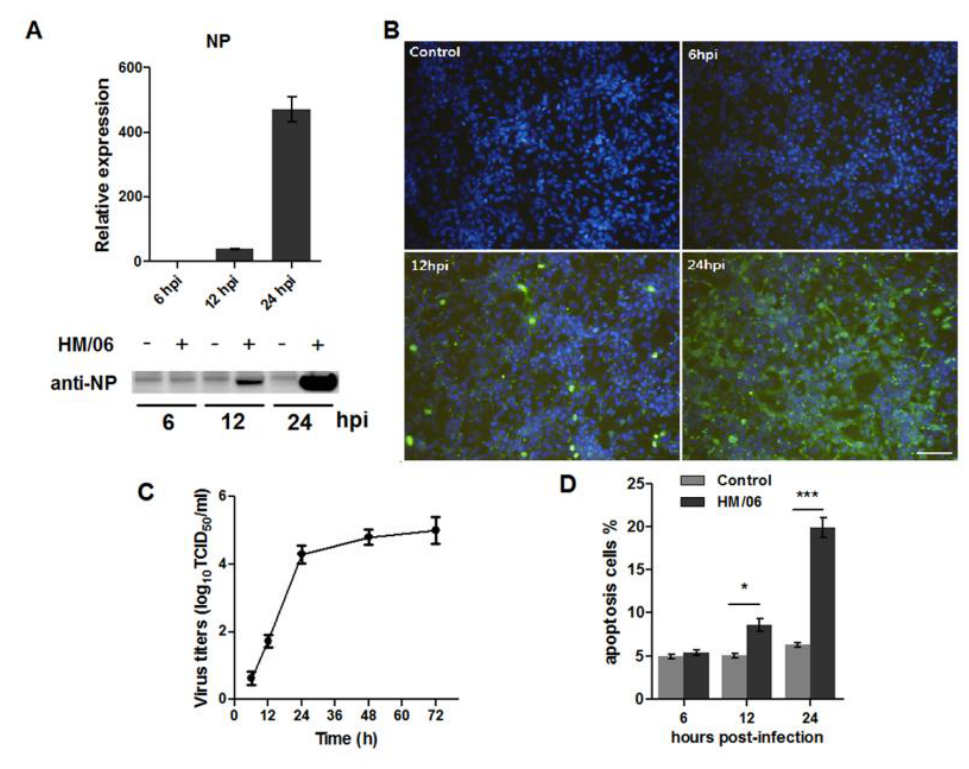
Figure 1. HM/06 replicated efficiently in U251 cells and induced apoptosis in U251; ( A ) U251 cells were infected by HM/06 at MOI 1.0, and cells were lysed for NP detecting by western blot at indicated times post-infection; ( B ) HM/06-infected U251 cells were fixed, permeabilized, and stained with corresponding antibodies for immunofluorescence observation with an OLYMPUSIX70microscope. Bar, 50 µm; ( C ) U251 cells were infected by HM/06 at MOI 1.0, and at indicated times post-infection, supernatants were collected and viruses titer were determined by TCID 50 in MDCK cells. Data was showed as means ± SEM from three experiments; ( D ) U251 cells were infected by HM/06, and at 6, 12, and 24hpi, cells were washed with PBS, detached from the culture plates. Apoptosis was detected